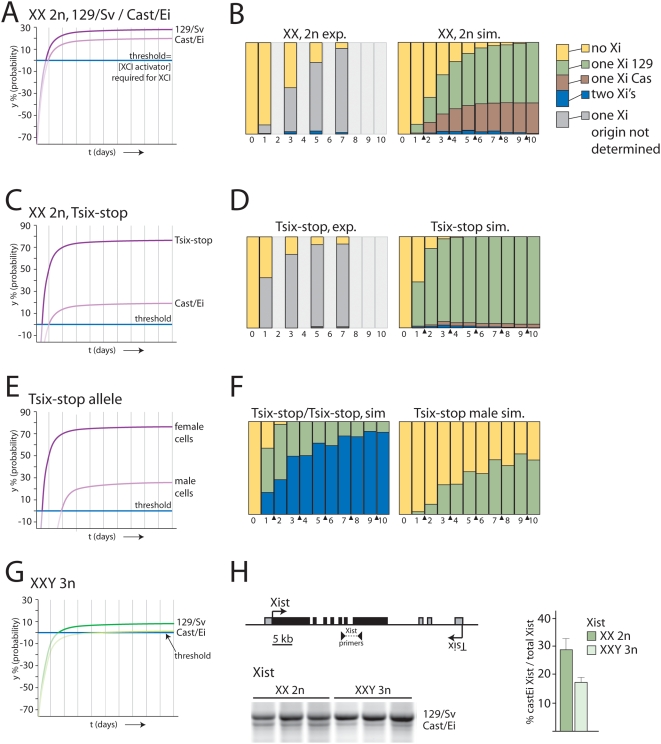
Implementing allele specific thresholds.A, B) XCI skewing can be simulated by attributing different probabilities to the two X chromosomes in female XX cells. To simulate the 30%:70% skewing of XCI observed in Cast/Ei – 129/Sv F1 mice and differentiating F1 ES cells different allele specific probabilities were applied. (B) The experimentally obtained XCI data (left panel) with differentiating XX Cast/Ei – 129/Sv F1 ES cells does not discriminate between inactivation of the Cast/Ei or 129/Sv X chromosome. Right panel shows simulations with allele specific probability curves presented in (A). C) Almost complete skewing of XCI towards the Tsix-stop containing 129/Sv X chromosome was simulated using allele specific probabilities for the Cast/Ei and mutated 129/Sv X chromosomes. D) Left panel shows the experimentally obtained XCI data with 2n XX heterozygous Tsix-stop female cells. In this experiment no discrimination was made between inactivation of the Cast/Ei and 129/Sv X chromosomes. The right panel shows simulated XCI experiments using the probability y presented in (C). E) Predicted probabilities in time for a Tsix-stop X chromosome in male and female ES cells. F) Left panel shows simulation experiments with homozygous female Tsix-stop cells. Right panel shows initiation of XCI occurring in simulation experiments with Tsix-stop male cells. G) Predicted probability curves for Cast/Ei and 129/Sv X chromosomes in 3n XXY ES cells. H) Schematic presentation of the Xist locus and the localization of the PCR primers used to determine skewing of Xist expression. RT PCR was performed with cDNA of 7 day differentiated 2n XX cells and 3n XXY cells, with Xist primers spanning intron 6, amplifying a length polymorphism present in exon 7. The average percentage, and standard deviation, of Xist emanating from the Cast/Ei X chromosomes relative to the total amount of Xist is shown in the right graph.